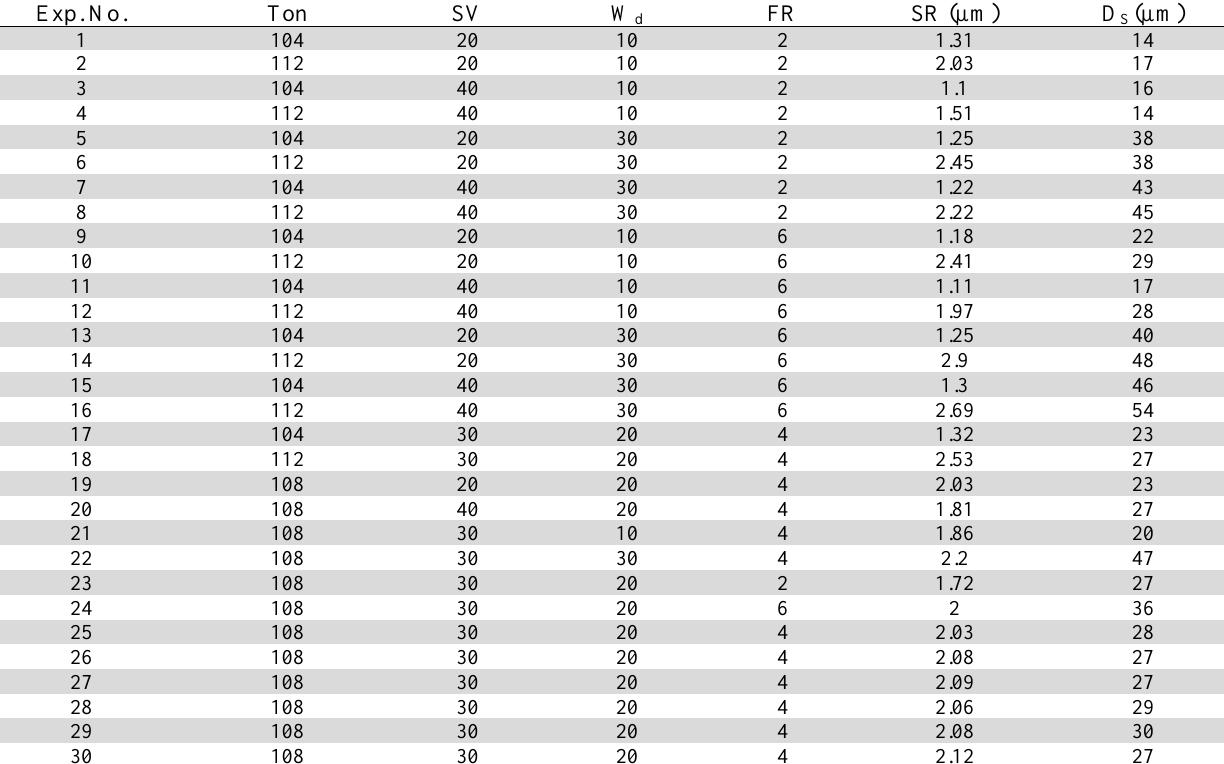
The layout of experimental design for Face CCD of second order and experimental results Exp.